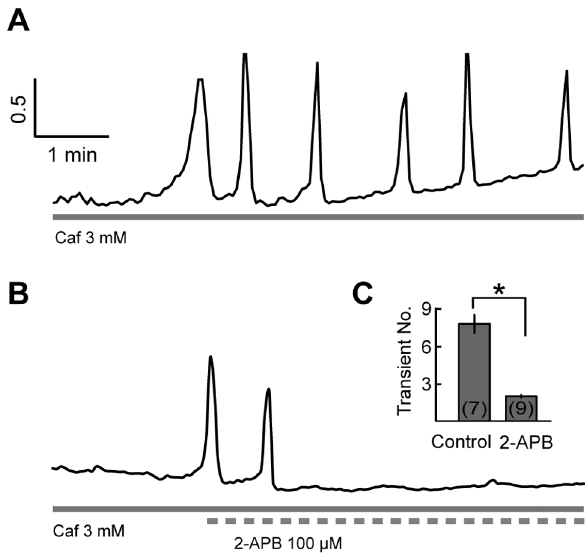
Figure 5. 2-APB effect on the caffeine-induced [Ca 2 + ] i oscilla- tions. A, [Ca 2 + ] i oscillations induced by prolonged application of caffeine (3 mM, 7 min). B, When 2-APB (100 m M) was co-applied, [Ca 2 + ] i oscillations elicited by 3 mM caffeine was abolished. C, The average number of Ca 2 + transients induced by caffeine (3 mM, 7 min) in the control group and the 2-APB group. * denotes statistical significance of p , 0.05 with independent-samples t test.